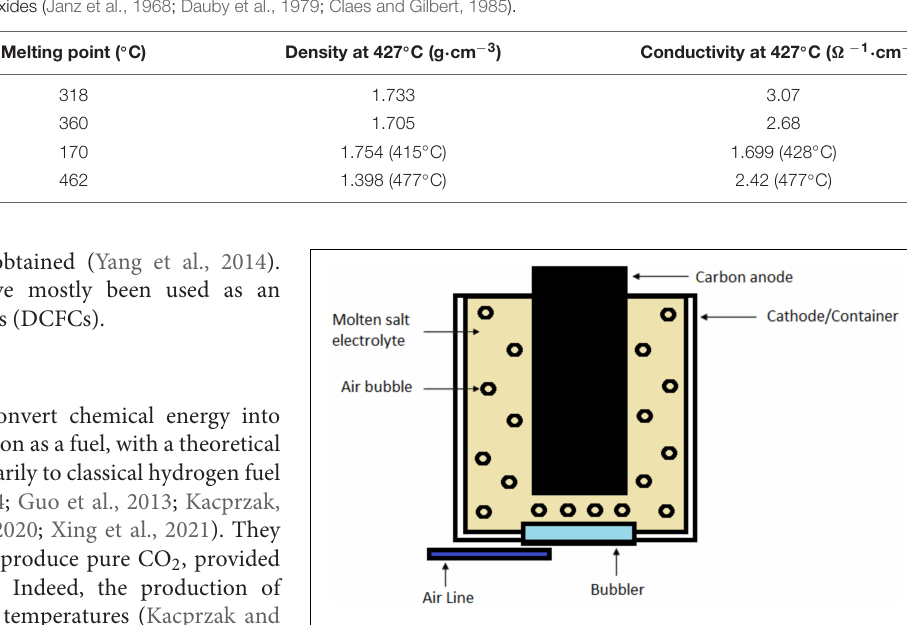
FIGURE 2 | General direct carbon fuel cell (DCFC)